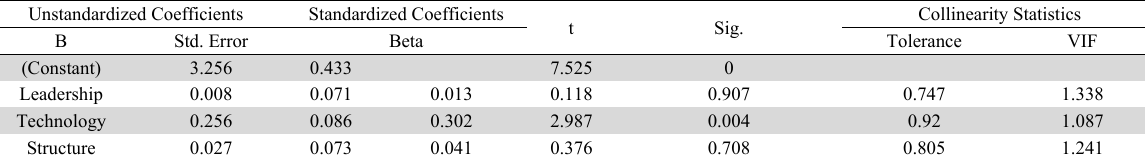
The results of regression analysis Unstandardized Coefficients